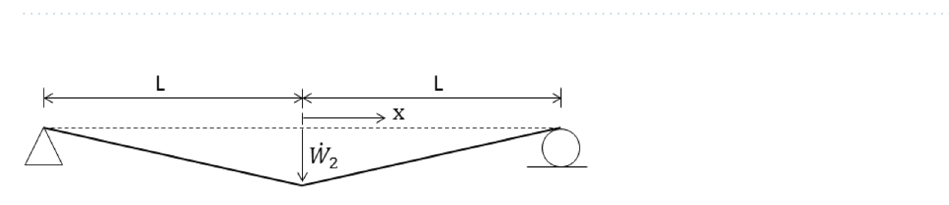
Figure 6. Sketch showing the distribution of transverse velocity during Phase 1 of motion.